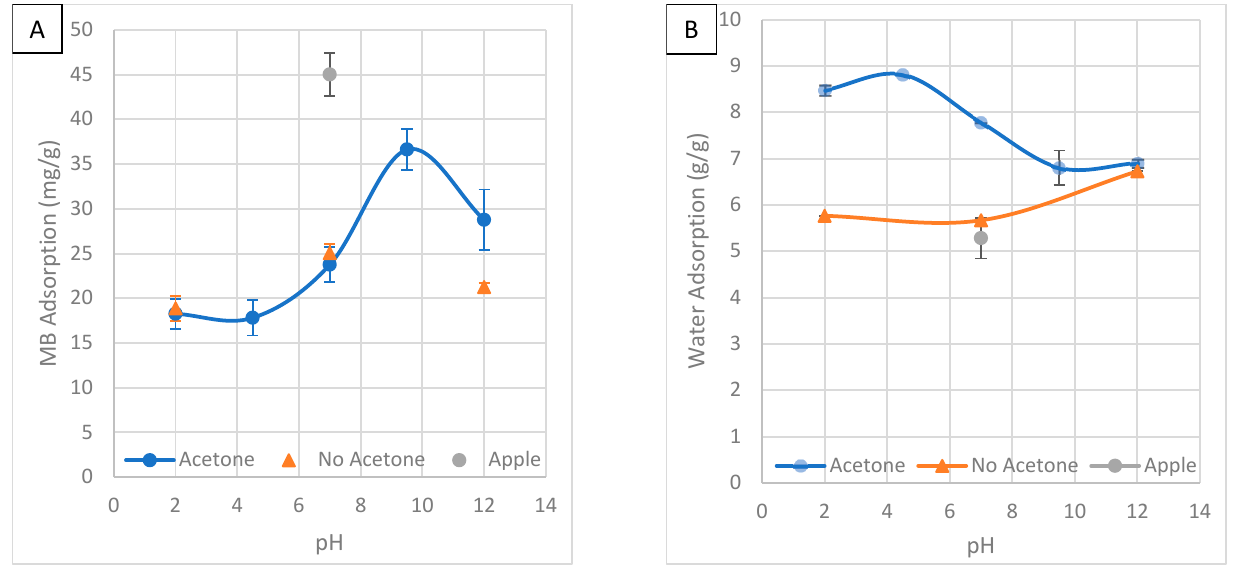
Figure 10. the effect of solution pH and washing with acetone on ( A ) MB adsorption and ( B ) water Figure 10. The effect of solution pH and washing with acetone on ( A ) MB adsorption and adsorption. ( B ) water